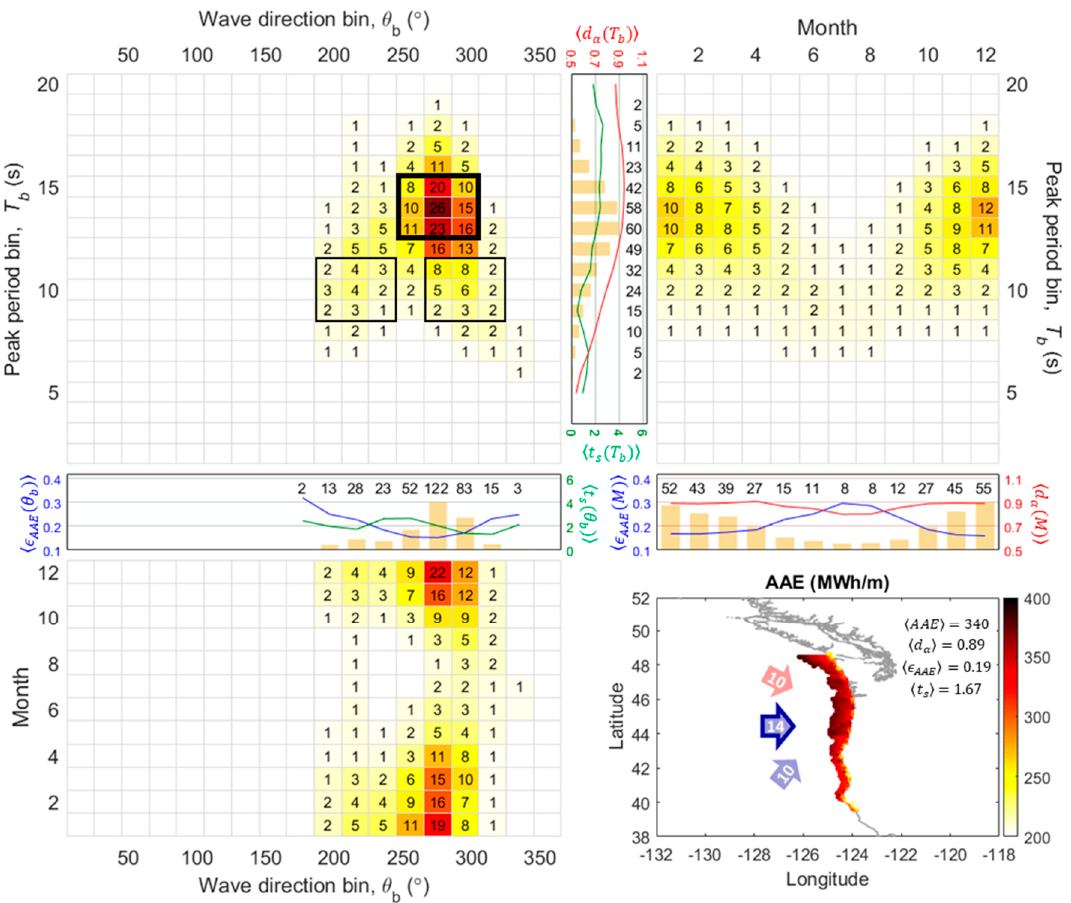
Figure 4. [Region 3: Pacific Northwest Coast] The detailed descriptions are identical to Figure 2.